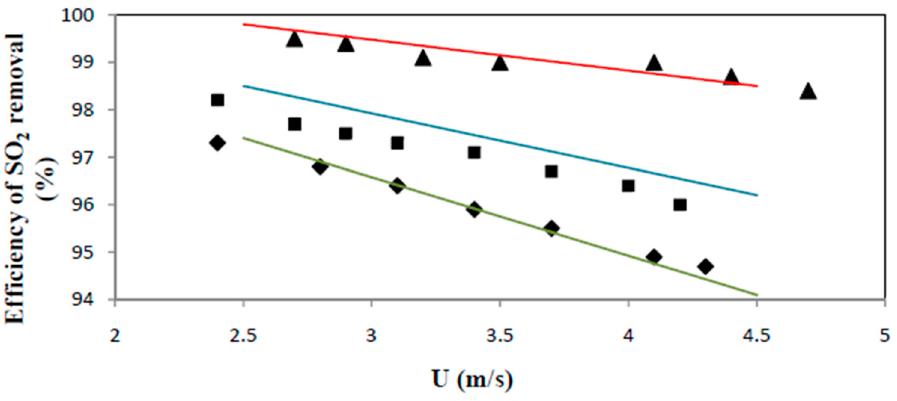
Figure 11. Comparison of experimental data and model predictions, at d p = 40 μ m. T = 1107 K, G = 36 kg/m 2 s; ■ T = 1135 K, G = 57 kg/m 2 s; ▲ T = 1135 K, G = 71 kg/m 2 s.; ─ , ─ , ─ Model prediction for , ■ and ▲ respectively.